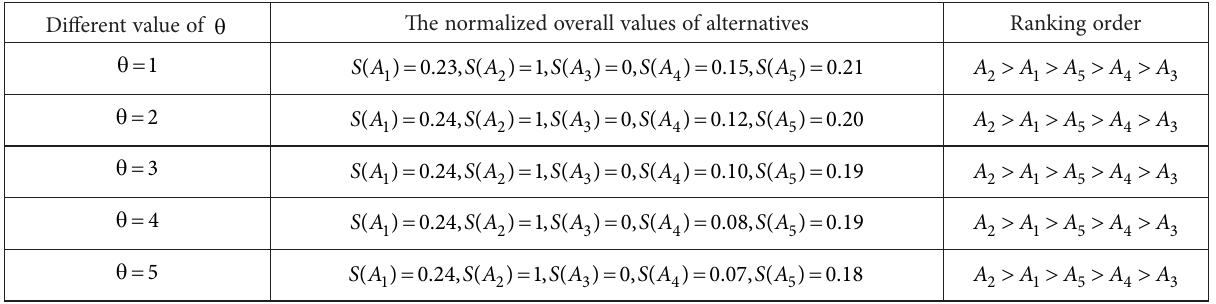
Different value of θ